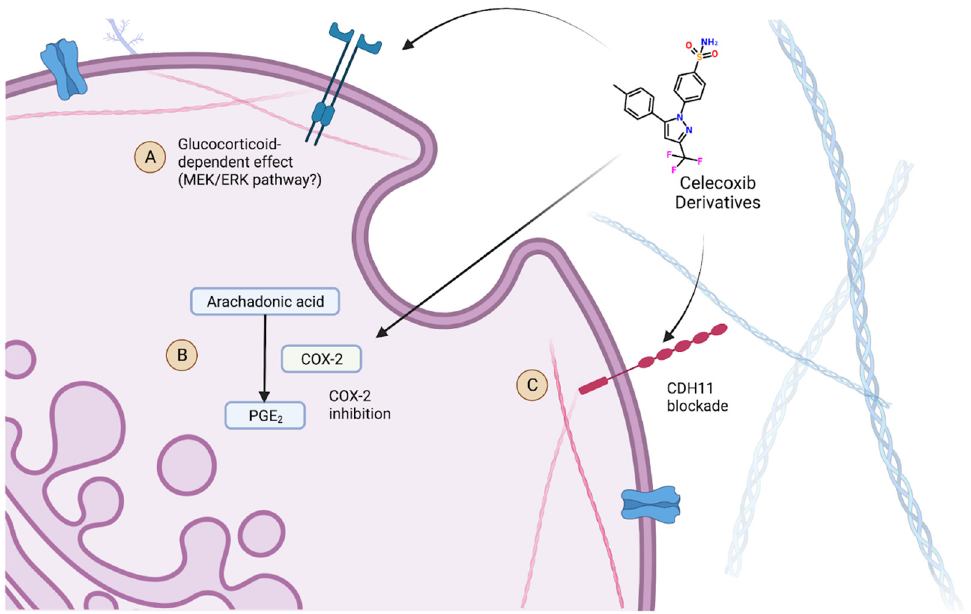
Figure 3. A summary of the pathways celecoxib and its derivatives that are proposed to affect (A) the glucocorticoid-dependent effect (possibly MEK/ERK), (B) the inhibition of COX-2, and (C) the blockage of the CDH11 transmembrane protein [9,19,23].